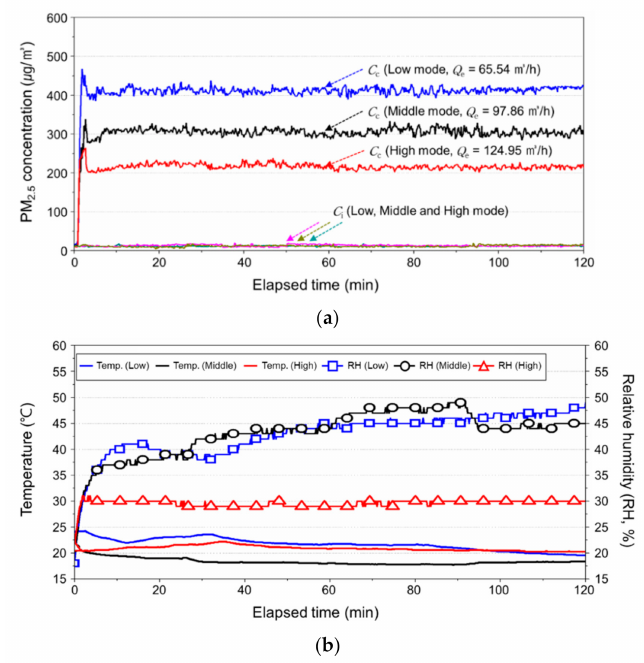
Figure 6. PM 2.5 concentration, temperature, and relative humidity at the measurement point during calibration: ( a ) PM 2.5 concentration; ( b ) temperature and relative